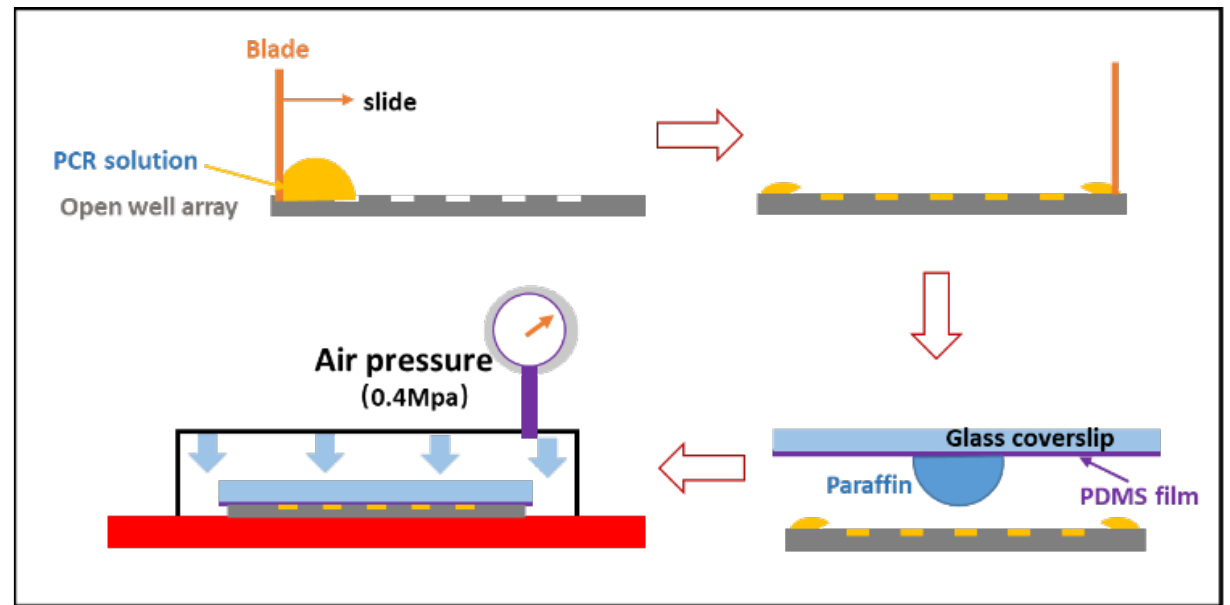
Figure 4. The diagram of sample loading and sealing for the SDA dPCR chip.